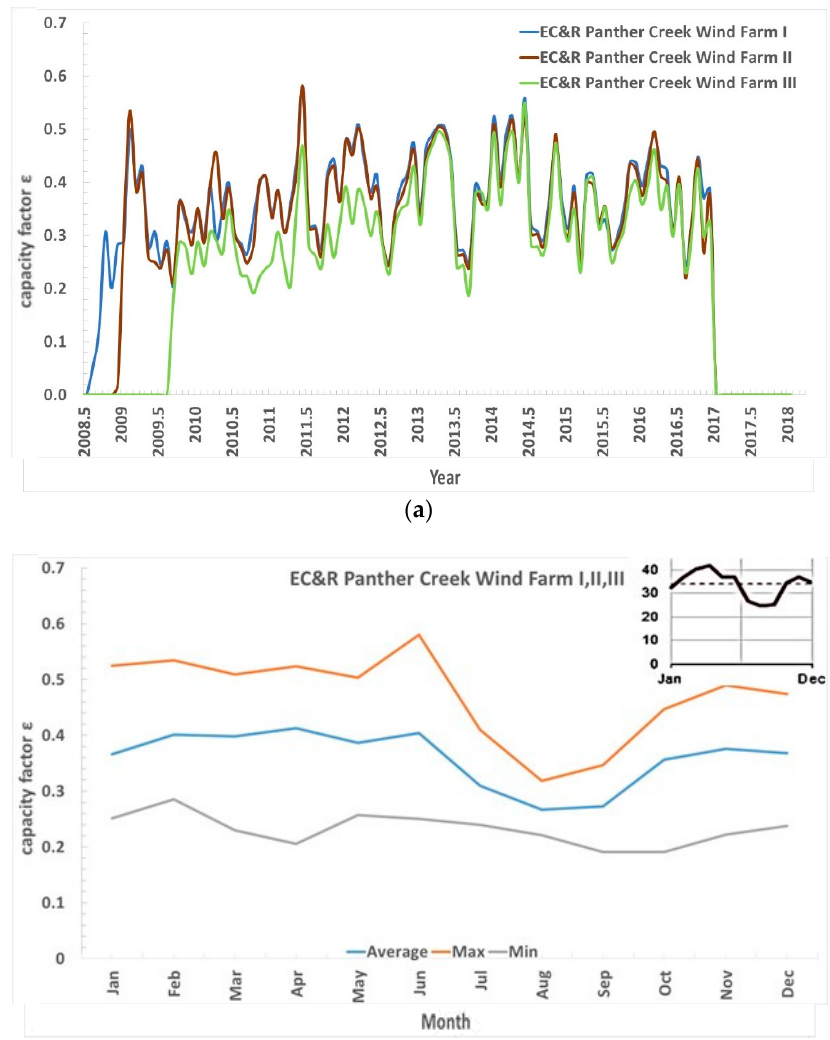
Figure 7. EC&R Panther Creek Wind Energy Center units. ( a ) ε m since the start of the operation of the individual WEFs. ( b ) Maximum, minimum, and average ε m of all the WEFs since the start of the operation of every WEF. The result compared with the reference seasonal variability for the Lower Plains according to [54], image reproduced modified after [54]. X-axis time, years ( a ), or months ( b ); Y-axis capacity factor ε (generating power vs. registered power) ε , non-dimensional. Table 5. EC&R Panther Creek Wind Energy Center (TX).